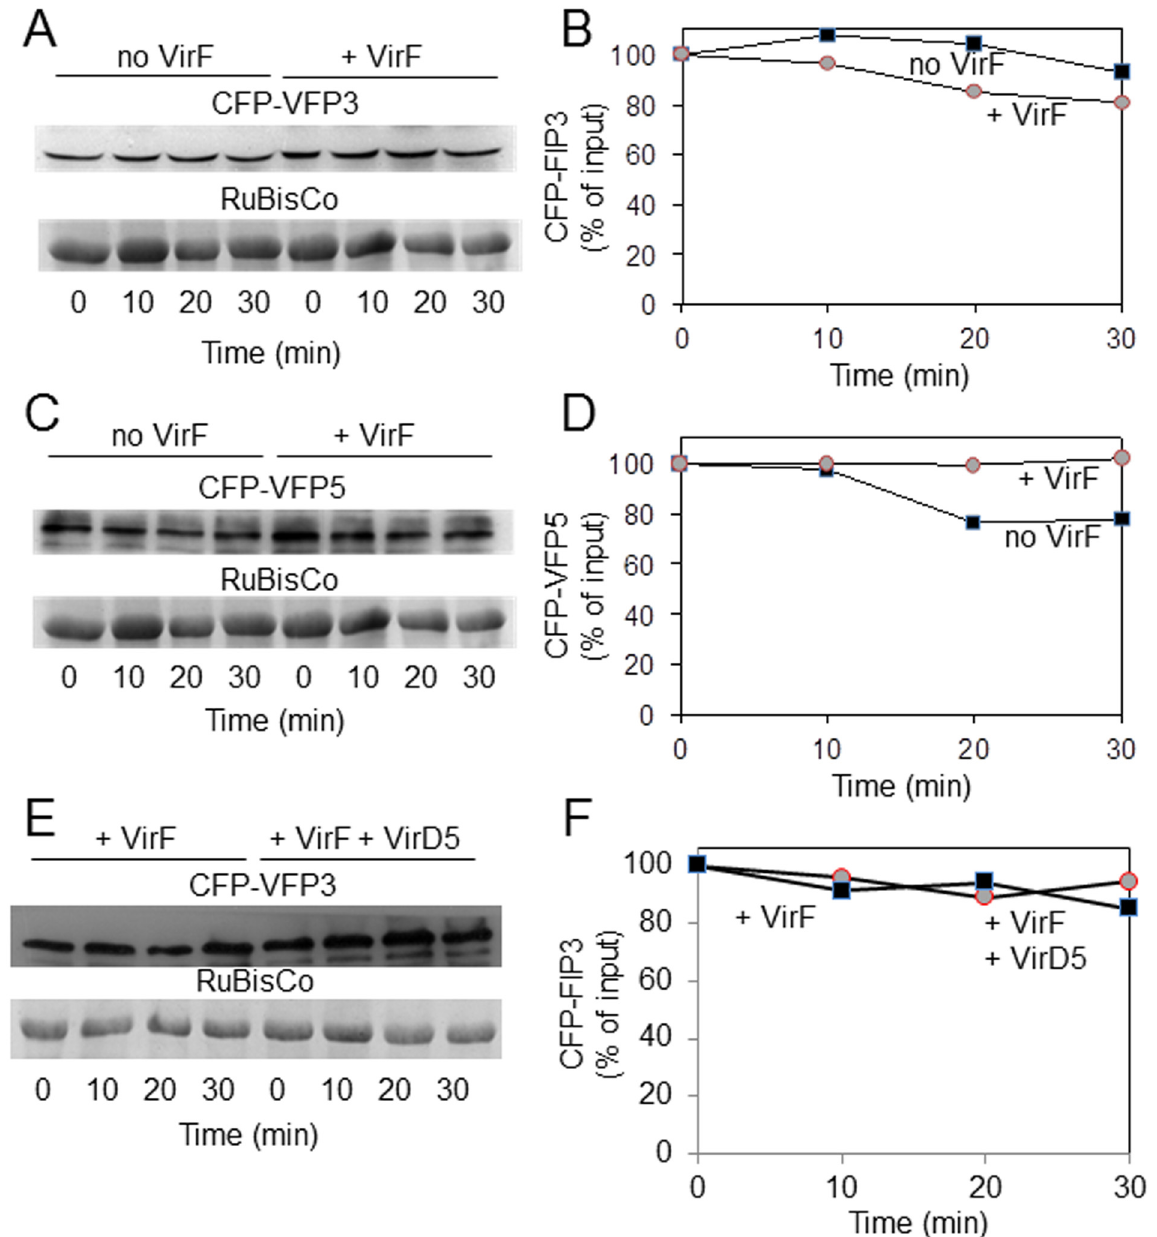
Fig 5. VirF does not destabilize VFP3 or VFP5 in a cell-free degradation assay. (A) Western blot analysis of CFP-VFP3 following coexpression with Myc- VirF. (B) Quantification of CFP-VFP3 accumulation described in (A). (C) Western blot analysis of CFP-VFP5 following coexpression with Myc-VirF. (D) Quantification of CFP-VFP5 accumulation described in (C). (E) Western blot analysis of CFP-VFP3 following coexpression with Myc-VirF and free VirD5. (F) Quantification of CFP-VFP3 accumulation described in (E). The tested proteins were coexpressed in N . benthamiana leaves, cell extracts were prepared and incubated for the indicated periods of time. CFP-VFP3 and CFP-VFP5 were detected by anti-CFP antibody, and RuBisCo was detected by Coomassie blue staining. The putative RuBisCo large chain was used as loading control and as reference for normalization of relative protein amounts. Each experiment was performed at least twice with similar